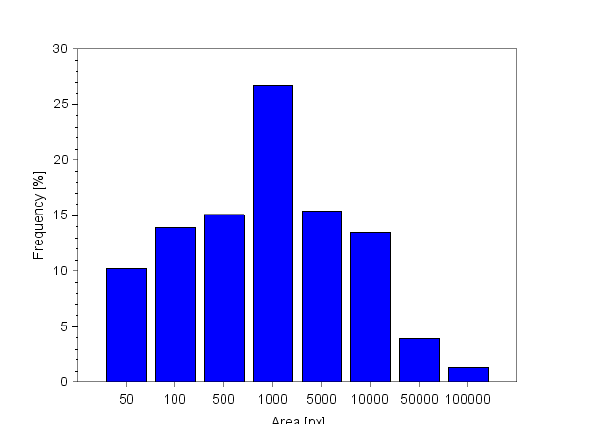
Figure 4. Distribution of size of detected areas in px. Intervals